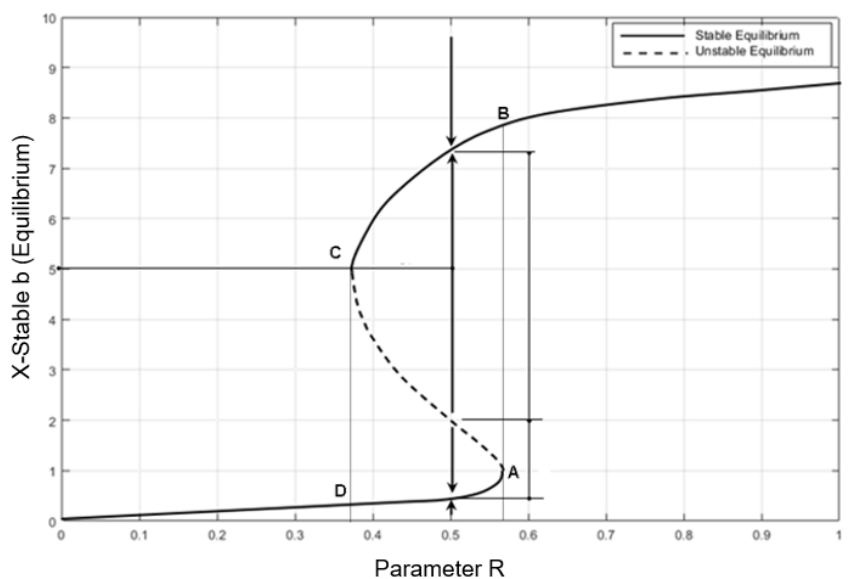
Figure 18. A modified bifurcation diagram (Case example 2).